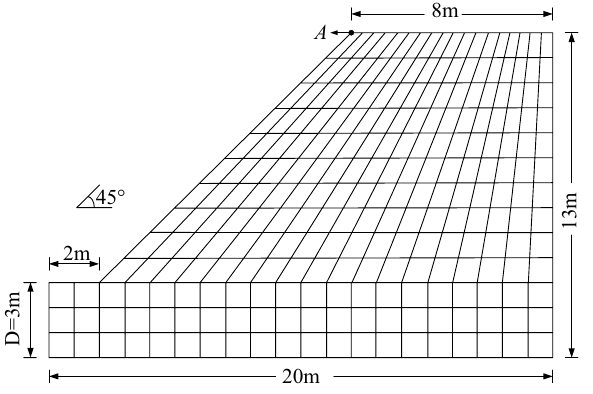
Figure 8. The discrete mesh of soil slope